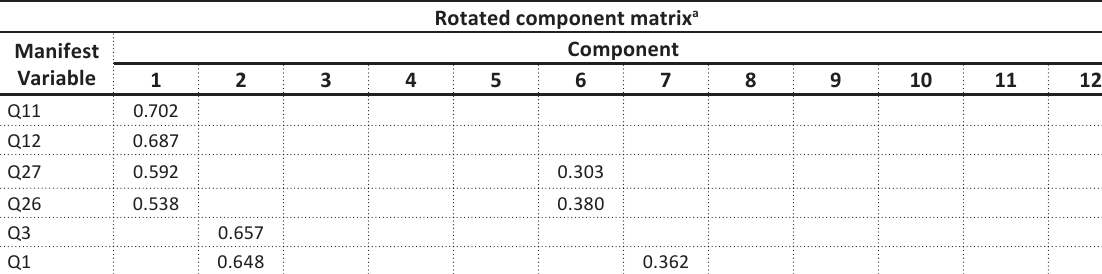
Table 3. Rotated component